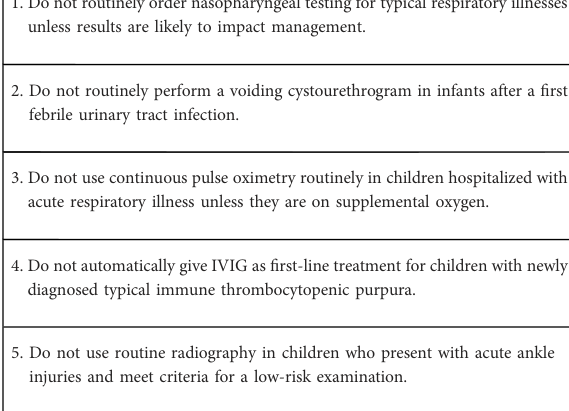
TABLE 1 Choosing Wisely list, recommendations by the Canadian paediatric society